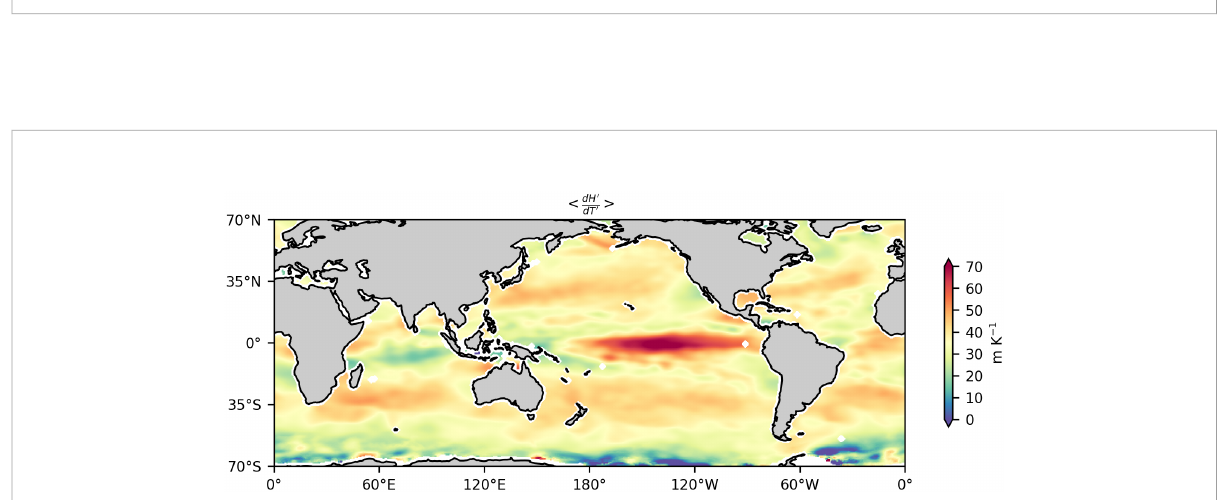
FIGURE 7 Standard deviation of (A) a B L , A recomputed by using time-mean dq sat dT j T = (cid:1) T and (cid:1) U 10 , (B) a D L , A recomputed by using time-mean dU ′ 10 / dT ′ , and (C) a B S , A recomputed by using time-mean (cid:1) U 10 . These quantities should be compared to their counterparts in Figure